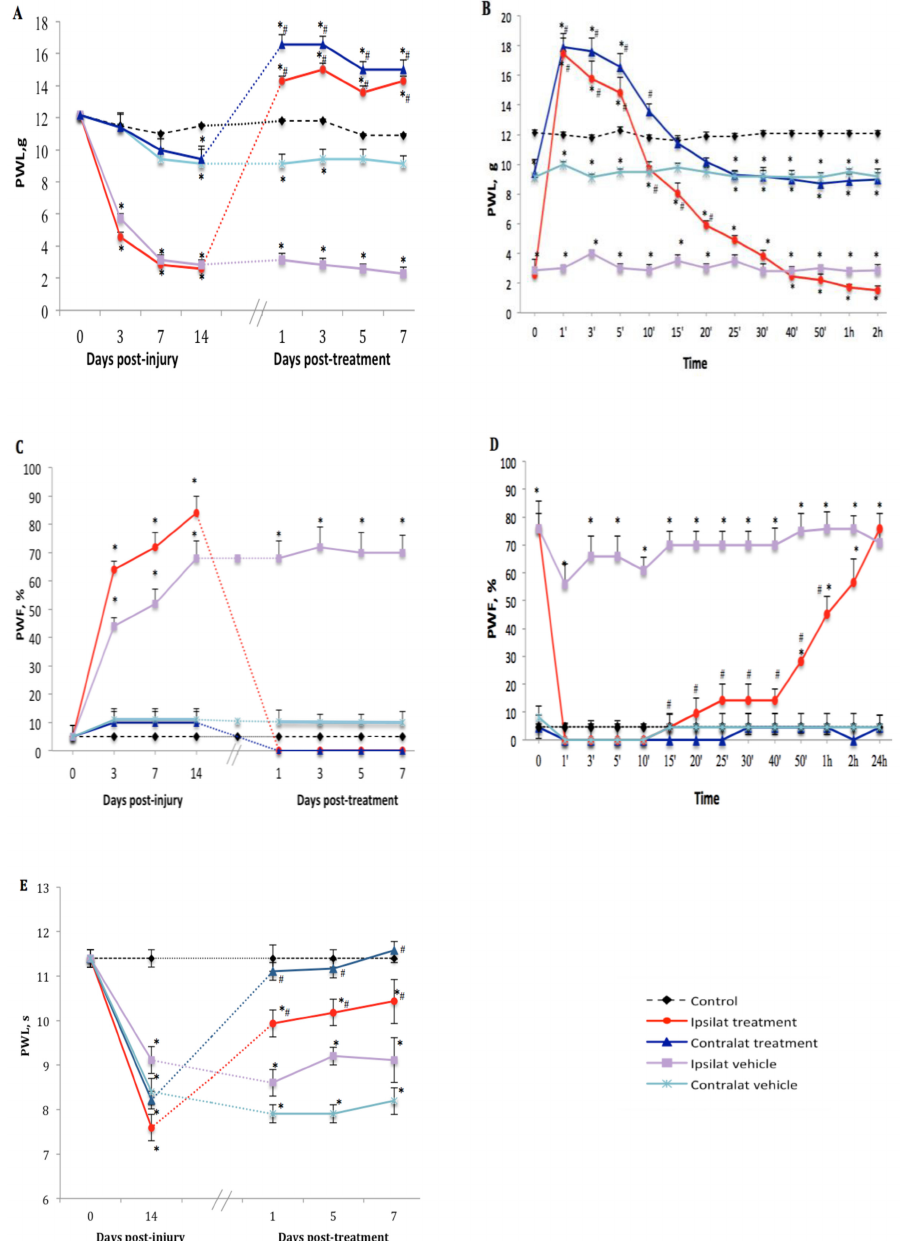
Figure 2. Nociceptive behavior after treatment with transient receptor potential vanilloid 1 (TRPV1) antagonist. E ff ect of one-week daily administration of SB366791 (1 mg · kg − 1 , i.p.) and its vehicle on mechanical allodynia ( A , B ), cold allodynia ( C , D ), and heat-hyperalgesia ( E ). Time-course inhibitory e ff ects of SB366791 on allodynia are given in B and D. Post-treatment values from days 1 to 7 in A and C represent the average of peak inhibition during the first 5–10 min post-administration. In E, PWL was still completely inhibited at 24 h post-treatment and therefore, the e ff ect of the antagonist was similar before and after administration. Thus, time-course e ff ect is not shown in E. Data represent the mean ± SEM of control ( n = 7), vehicle-treated ( n = 7) and SB366791-treated ( n = 8) groups. At some points, SEM are not visible because they overlap with the points. Control values are from the ipsilateral sham-operated side of untreated rats. Statistical comparison to control is indicated by * p < 0.05, (F = 5.98, p < 0.001), and to vehicle by # p < 0.05, (F = 5.98, p < 0.001), for all three types of